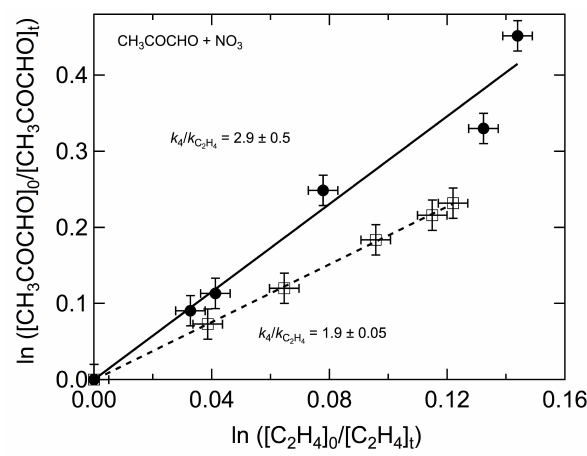
Fig. 7. Loss of methylglyoxal versus the reference compound, C 2 H 4 , in relative rate study for the NO 3 reaction at 296K in 650Torr of dry